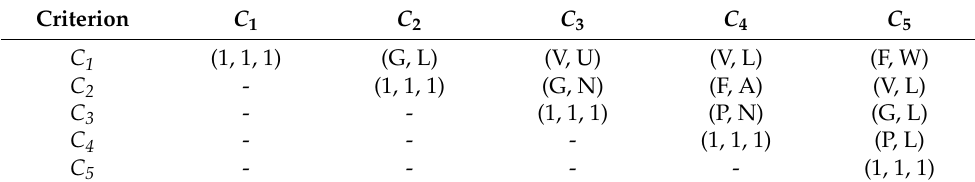
Table 8. The fuzzy comparison matrix of managers for the criteria.